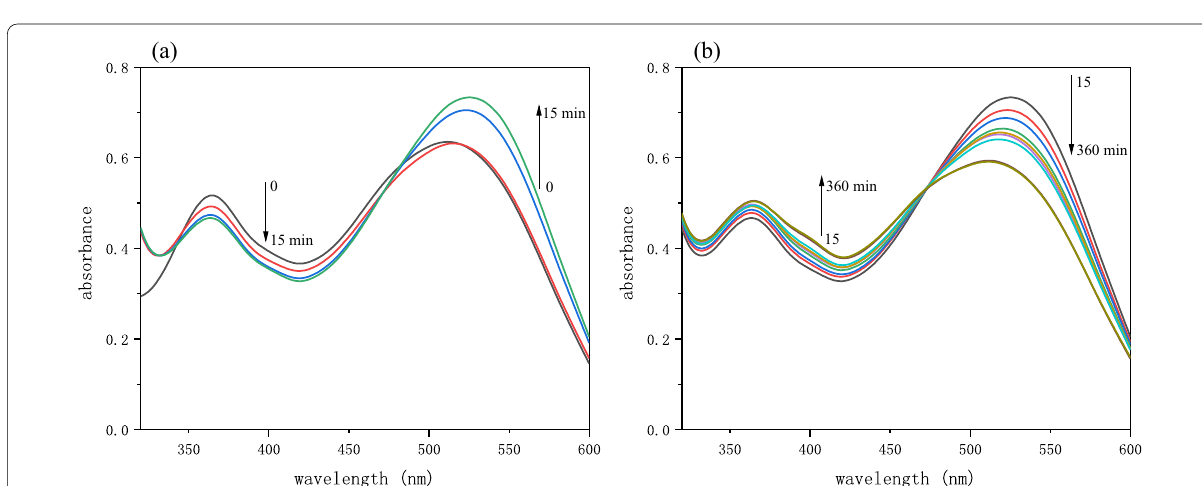
Fig. 9 Time-dependent absorption spectra of probe BCD (60 µM) at different time scales upon addition of GSH (1 mM) in DMF-Hepes buffer (8/2, v/v, pH =